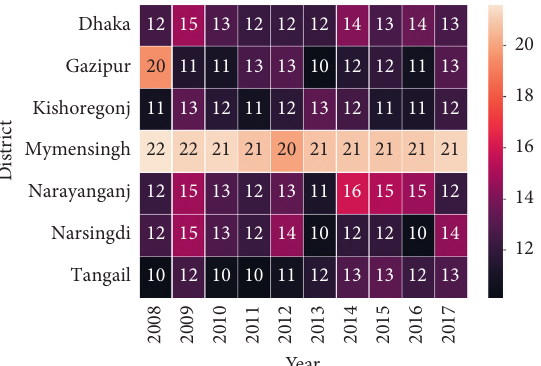
Figure 2: Analysis of minimum temperature from 2008 to 2017 against district.